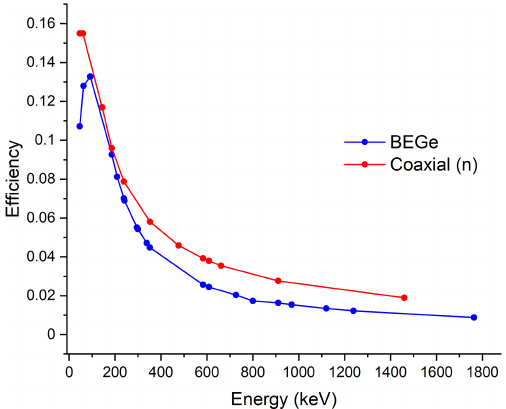
Figure 3. Typical efficiency data for two detectors with diameters close to 60mm. Data were determined with samples in the form of discs covering the front face of the detector. Samples have a diam- eter of 60mm and a thickness of 13mm. Data were normalized at low energy to account for the small difference in diameter of the two detectors. See Table 1 for a description of BEGe and coaxial ( n ) of this